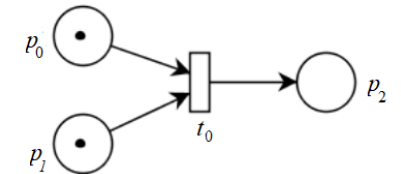
Figure 8. QPN model of a qubit rotation depending on another one.